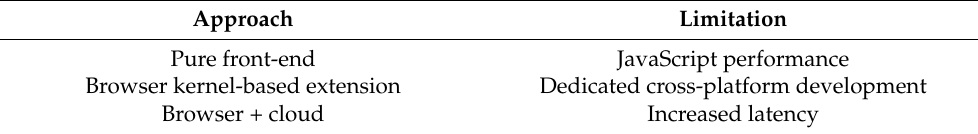
Table 1. Limitations found in the presented Web Augmented Reality development